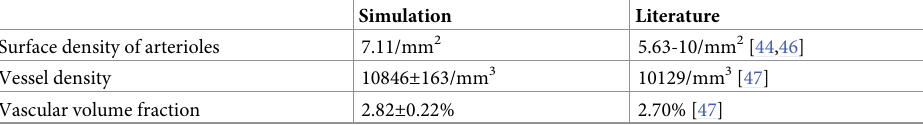
Table 1. Geometric information of cortical